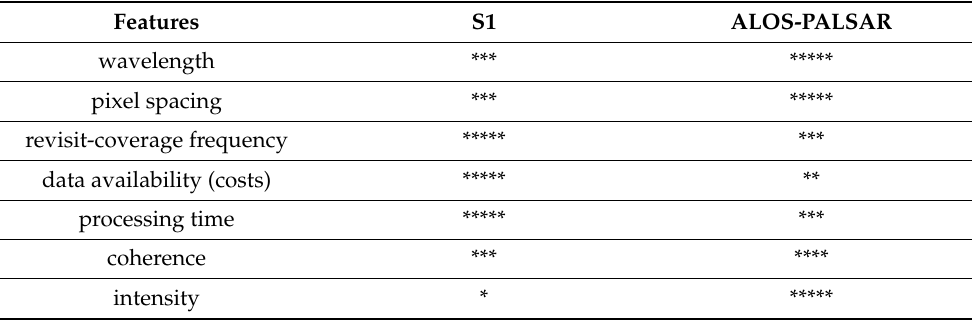
Table 4. Comparison of S1 and ALOS-PALSAR satellites regarding landslide detection purposes [97,98]. Asterisk: relative scale